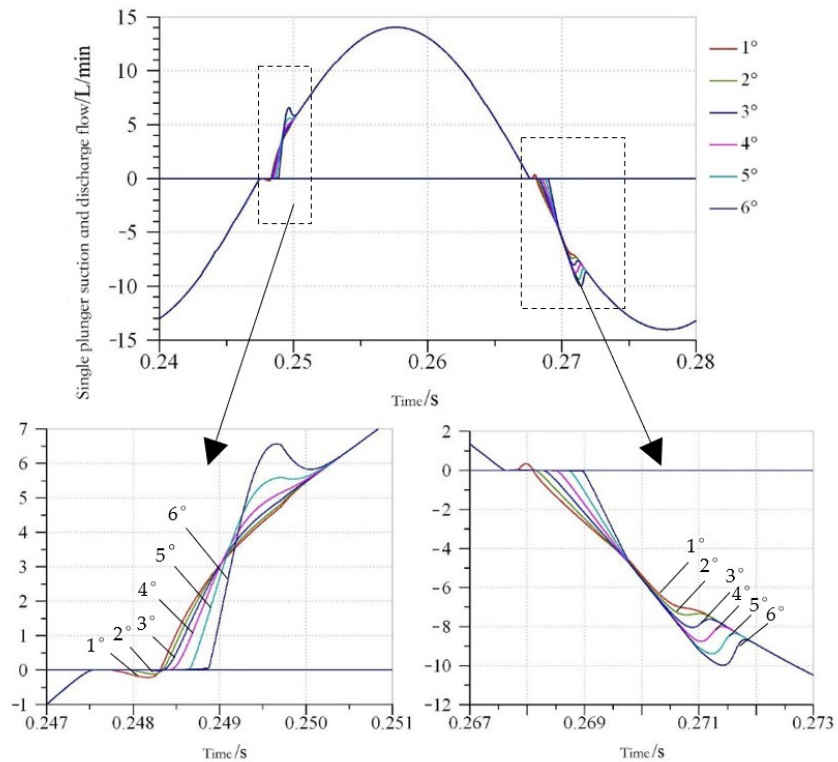
Figure 20. The curve of inlet and outlet flow rate of single piston for Δ φ/ 2 = φ 0 =